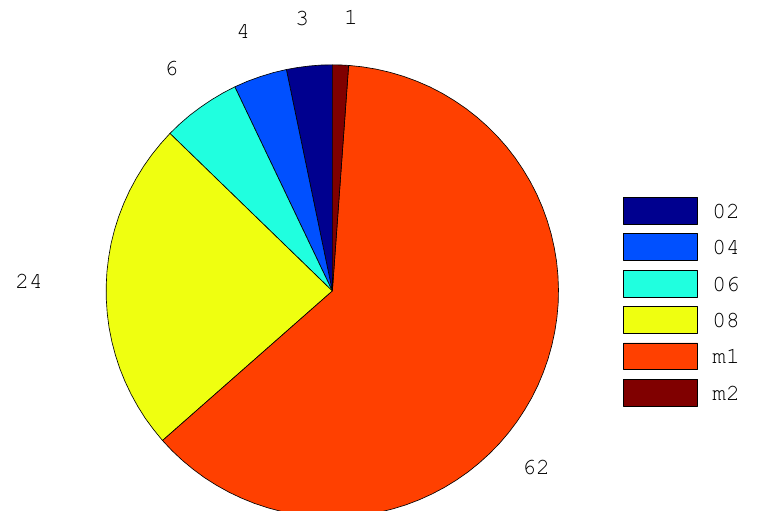
Figure 8. Pie chart of the error (absolute value), grouped by measuring ranges (mm), between the measured construction lengths and those obtained by solving for equilibrium in System (1).